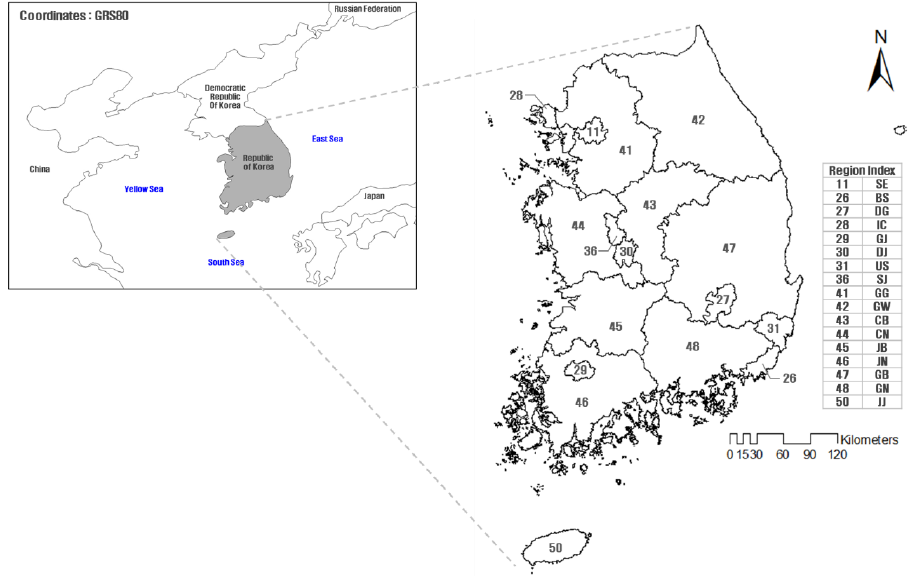
Figure 1. Study area in South Korea.